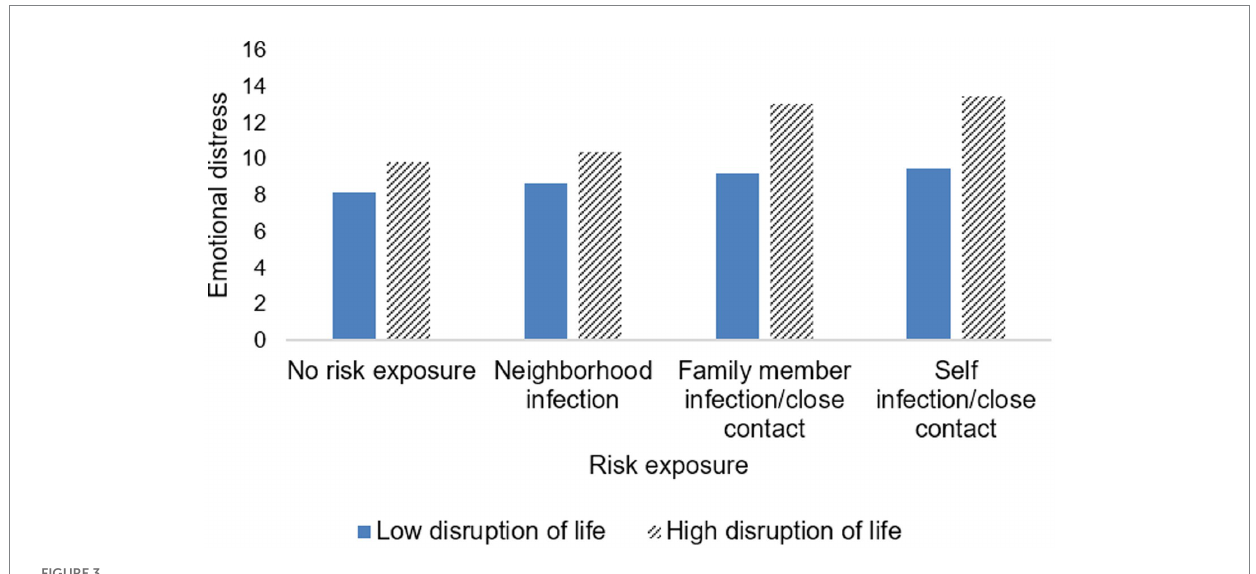
FIGURE 3 The interaction effect of risk exposure and disruption of life on emotional distress.